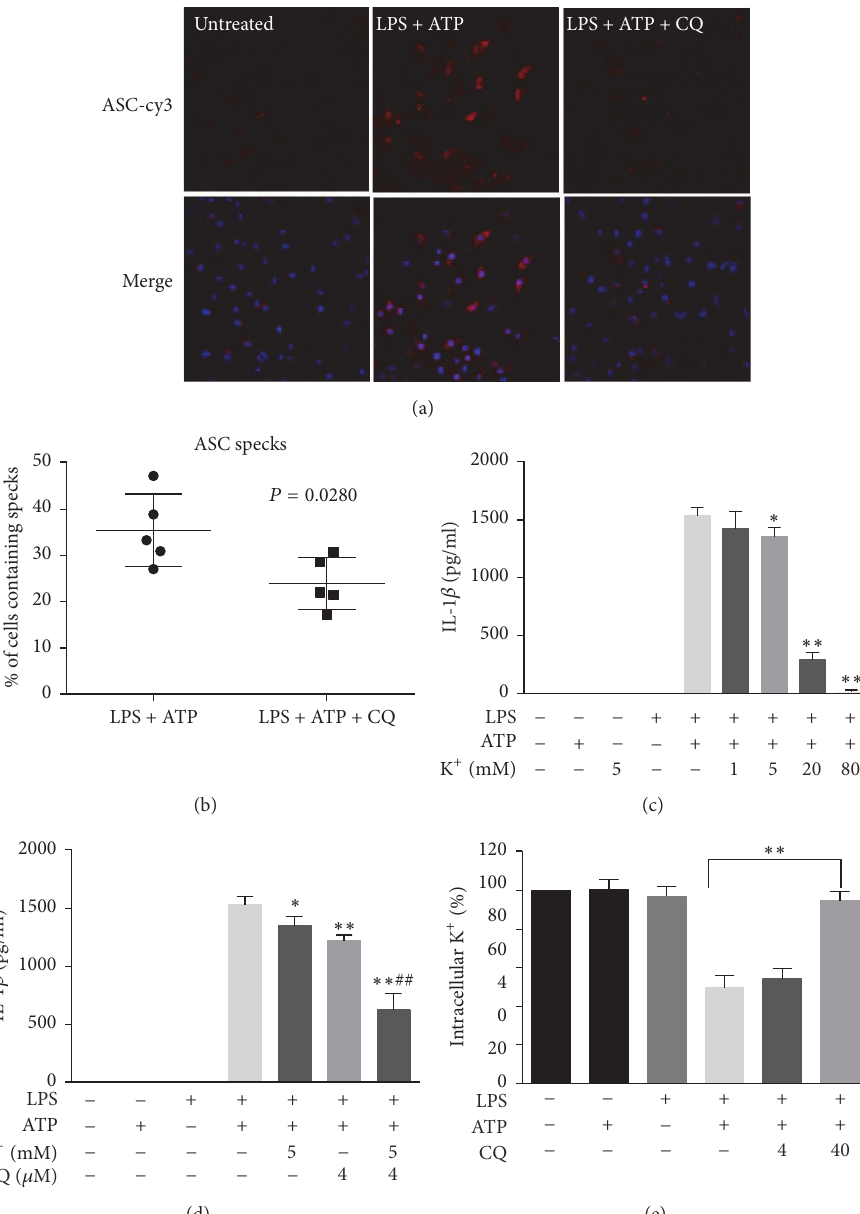
Figure 5: CQ restrains ASC speck formation and potassium efflux. (a) Representative immunofluorescence images of ASC speck formation in LPS-primed BMDMs stimulated with ATP in the presence or absence of CQ (20 𝜇 M) were acquired by confocal microscopy. (b) A percentage of cells containing specks were quantified in at least five distinct fields. (c, d) LPS-primed BMDMs were treated for 1h with 2mM ATP in a medium containing the specified [K + ], and the secreted IL-1 𝛽 was measured. (e) CQ pretreatment BMDMs were treated with LPS plus ATP, and the intracellular content of K + was detected. Data are shown as means ± SEM; ## 𝑃 < 0.01 versus CQ pretreatment (4 𝜇 M) group; ∗ 𝑃 < 0.05 , ∗∗ 𝑃 < 0.01 versus LPS plus ATP